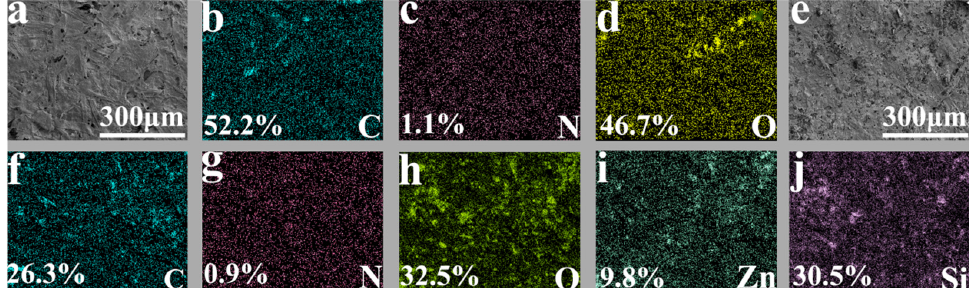
Figure 4. ( a ) EDS diagram of base paper mulching film surface, ( b ) Distribution map of C